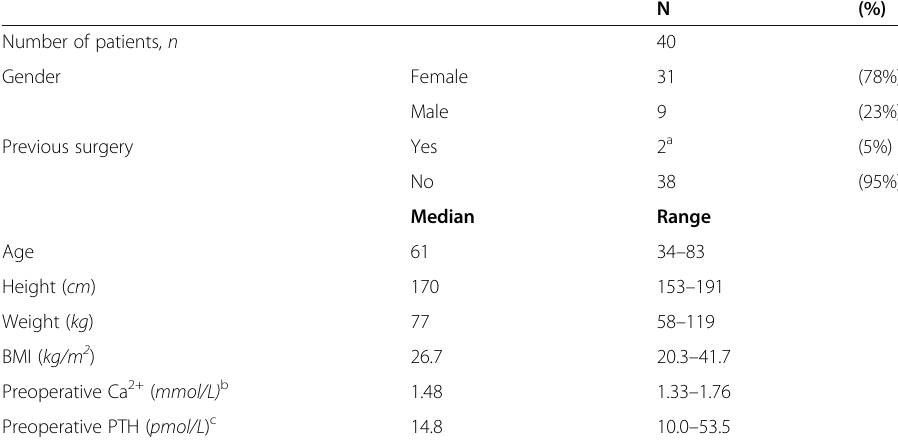
Table 1 Baseline patient